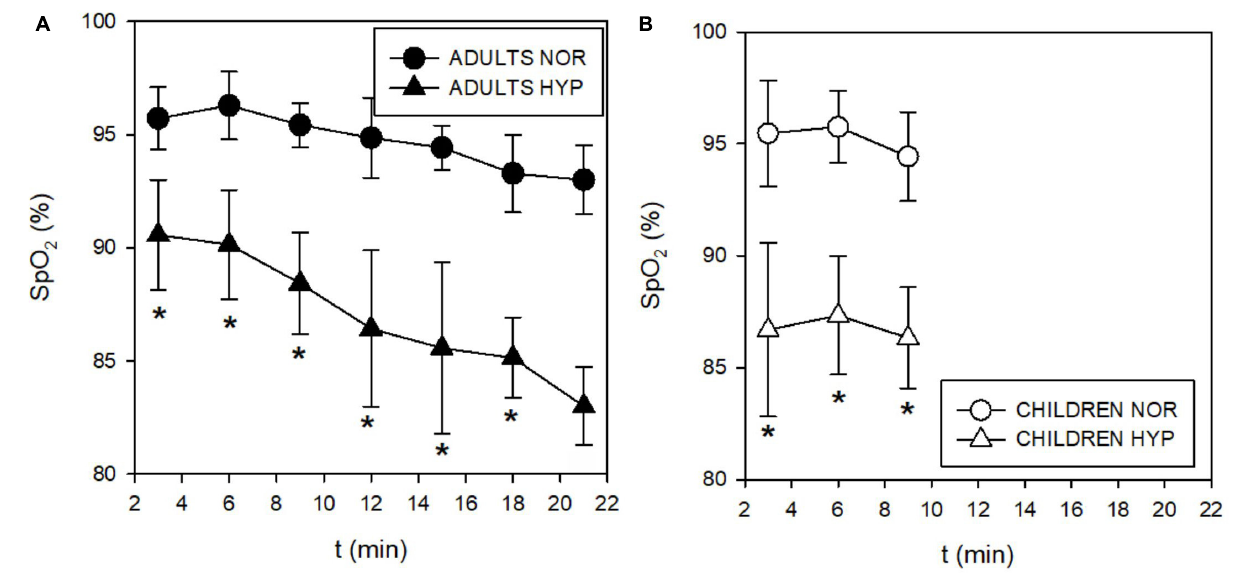
FIGURE 2 | Time course of changes in capillary oxygen saturation (SpO 2 ) during incremental test in adults (A) and children (B) . The SpO 2 decreased in both adults and children during hypoxic conditions.